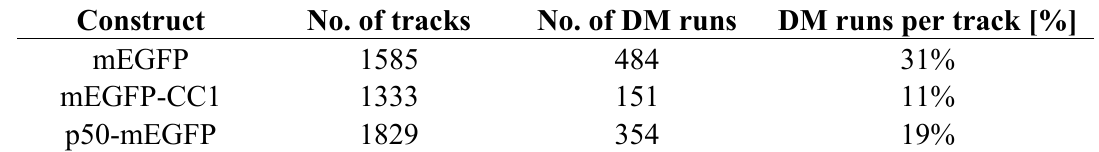
Table 1. Dynactin interference reduces the number of directed motions (